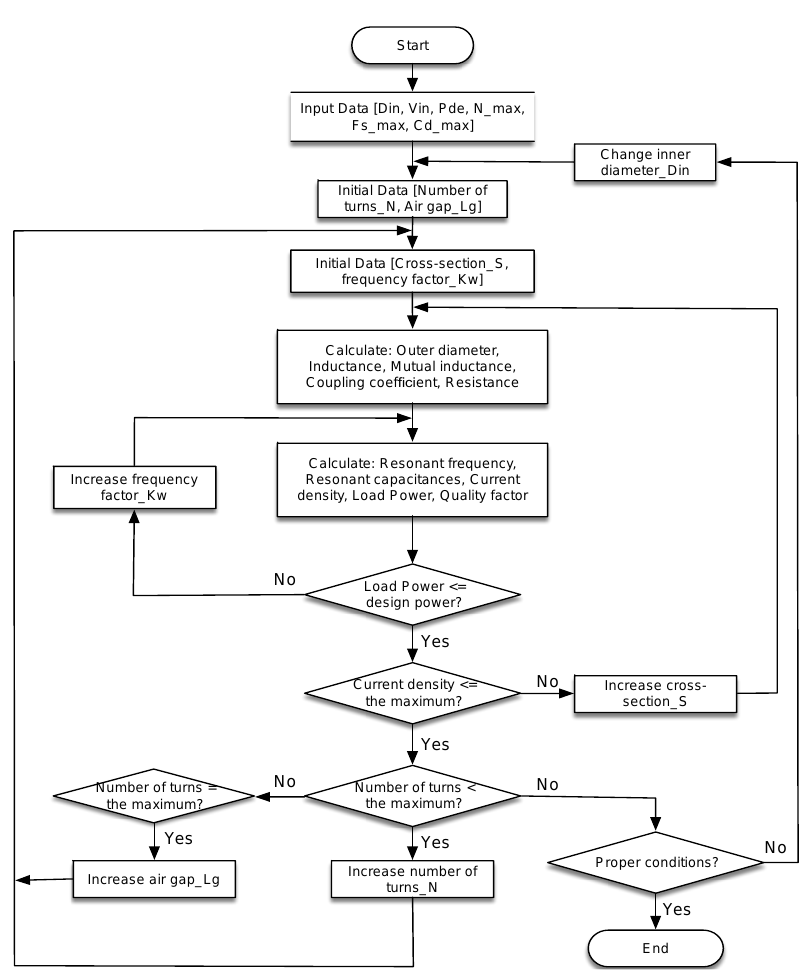
Figure 5. Flowchart of coil size optimization.